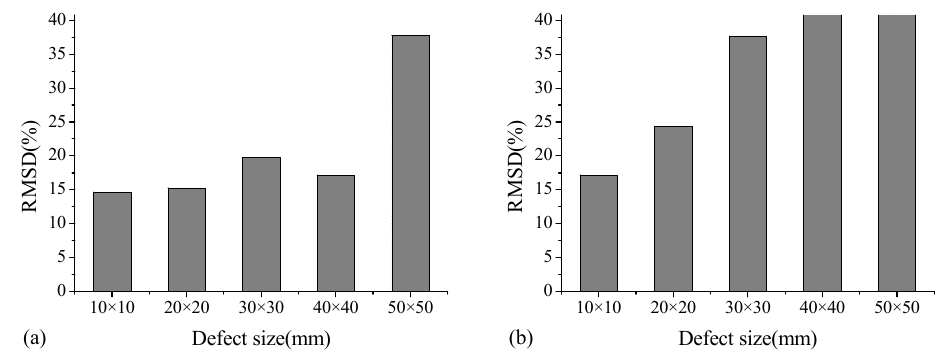
Figure 7. RMSD values of A ‐ type specimen at the frequency ranges of ( a ) 6000–8000 kHz and ( b ) 10,000–12,000 kHz.